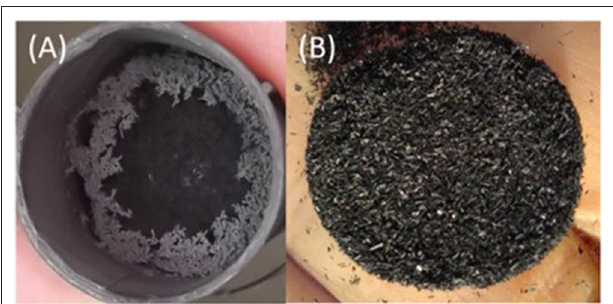
FIGURE 10 | Solid residue after biomass gasification over iron oxide (25w%): (A) sample holder containing the residue (B) : char and reduced iron oxides pellets recovered at the bottom of the sample